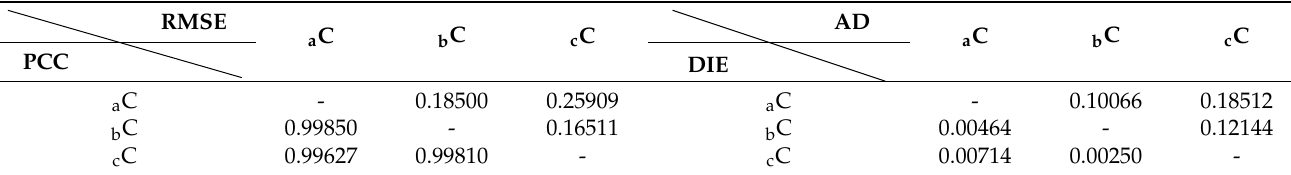
Table 3. Root Mean Square Error ( RMSE ) , Average Deviation ( AD ), Pearson Correlation Coefficient ( PCC ), and Difference of surface Information Entropy ( DIE ) for separate pairs of parabolic interpolation approximations a C , data from Figures 2, 8 and 9. Taken from